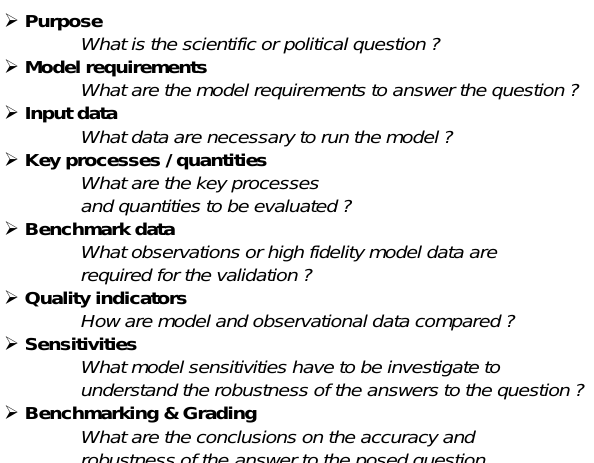
Overview on the ACCENT model evaluation protocol